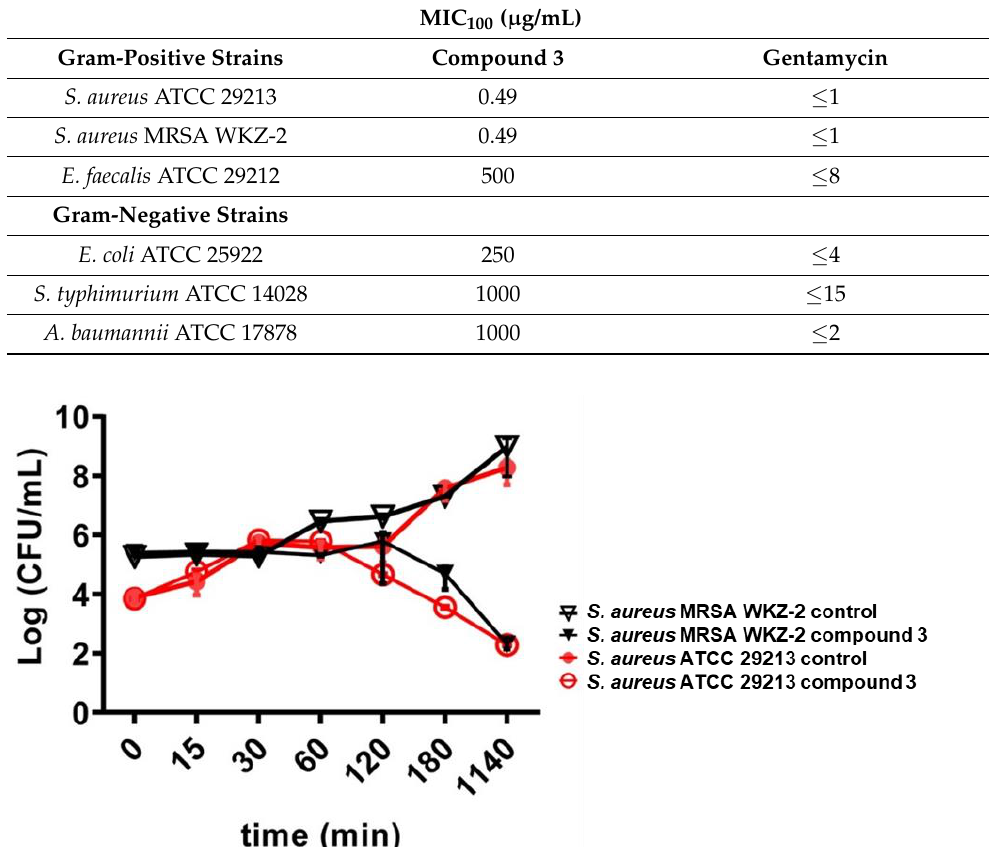
Table 2. MIC 100 values (µg/mL) determined for the compound kaempferol-3- O - α - L - (2″,4″ -di- E - p -